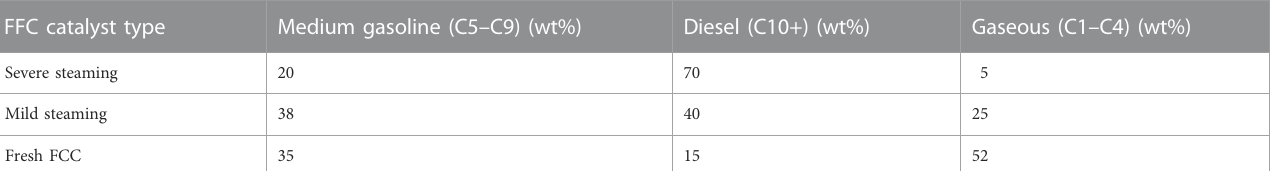
TABLE 8 FCC fresh and steaming product distribution (Olazar et al.,